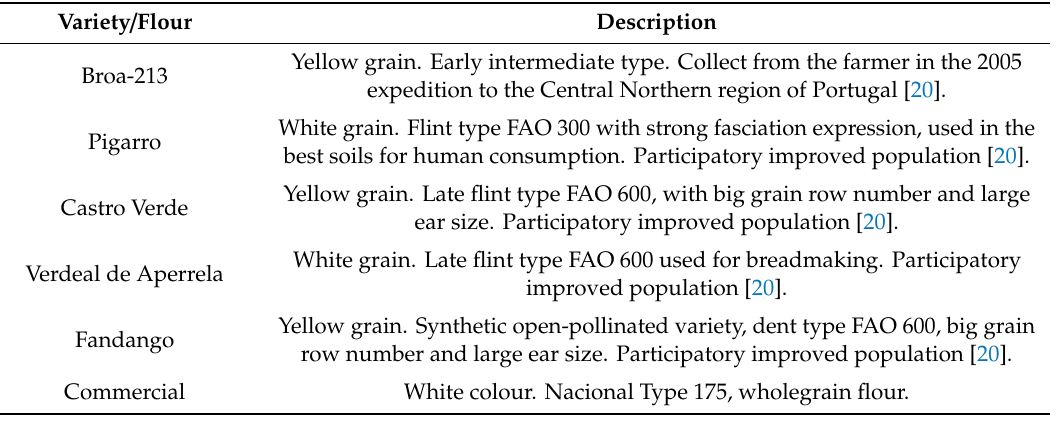
Table 1. Description of the maize varieties or flour used in the production of broas. Variety / Flour Description Yellow grain. Early intermediate type. Collect from the farmer in the 2005 Broa-213 expedition to the Central Northern region of Portugal [20]. White grain. Flint type FAO 300 with strong fasciation expression, used in the Pigarro best soils for human consumption. Participatory improved population [20]. Yellow grain. Late flint type FAO 600, with big grain row number and large Castro Verde ear size. Participatory improved population [20]. White grain. Late flint type FAO 600 used for breadmaking. Participatory Verdeal de Aperrela improved population [20]. row number and large ear size. Participatory improved population